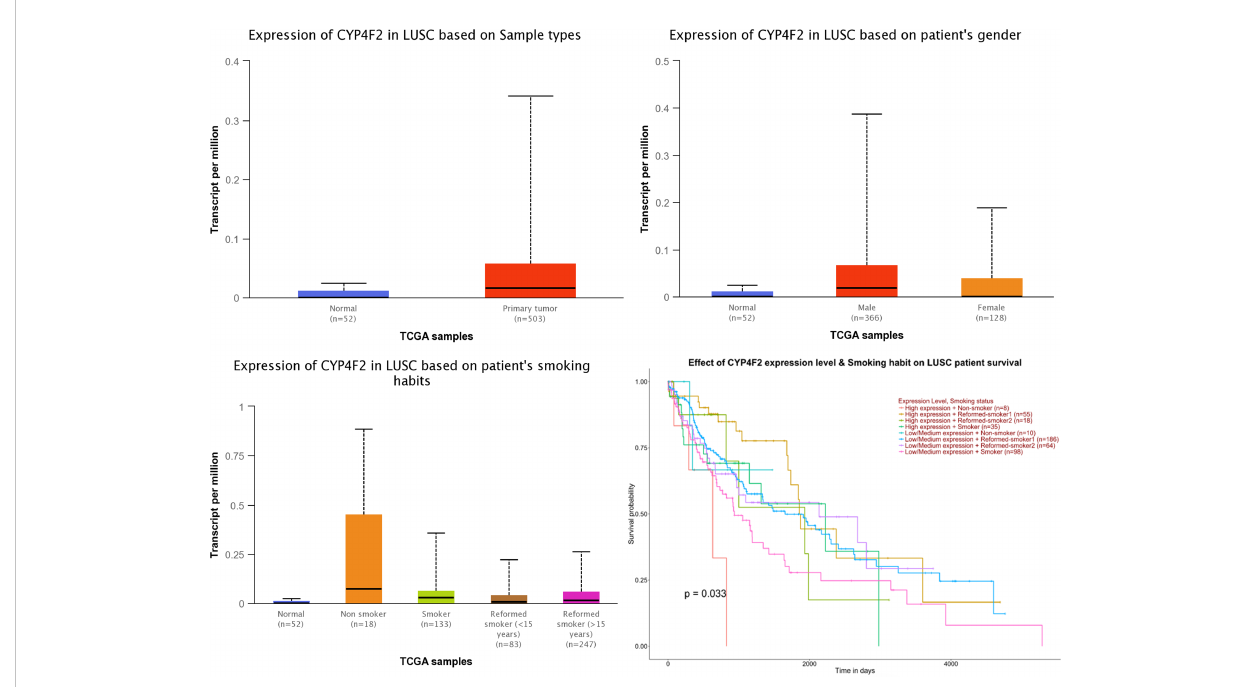
FIGURE 2 The expression of CYP4F2 in normal lung squamous cell carcinoma tissues based on different